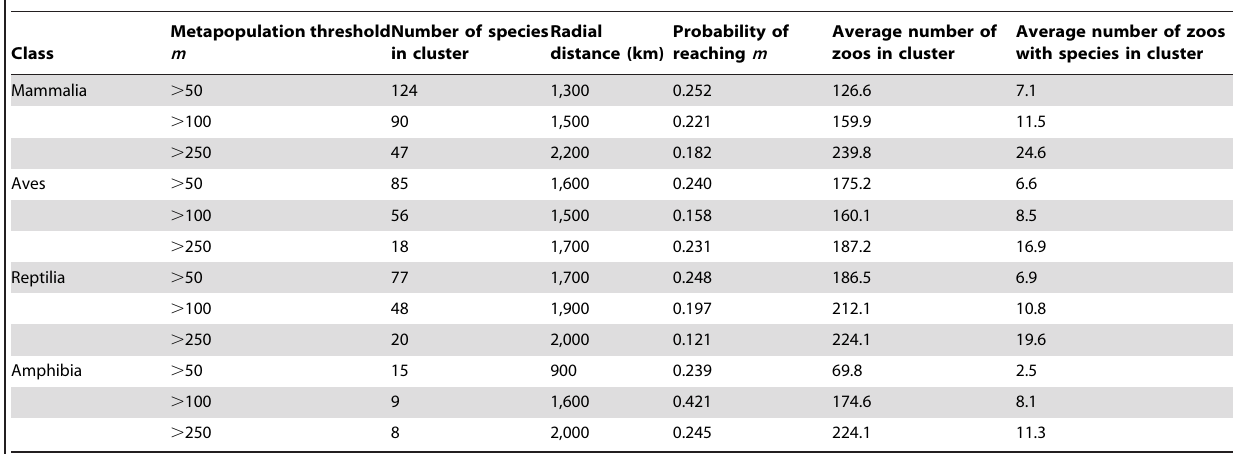
Table 4. Optimal radial distance between zoos in a metapopulation network for each taxonomic class of terrestrial vertebrates.